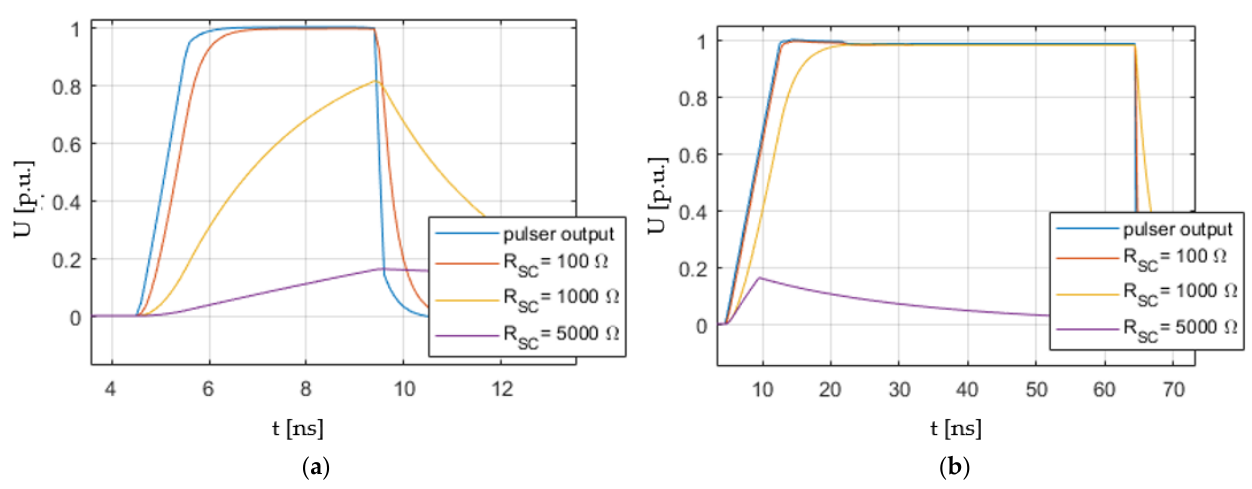
Figure 9. Impact of semicon resistance on pulser rise time at the sample, calculated for C = 500 pF, C sample = 2.4 pF R SC —variable, ( a ) t r = 1 ns t w = 5 ns, ( b ) tr = 10 ns, t w = 60 ns.